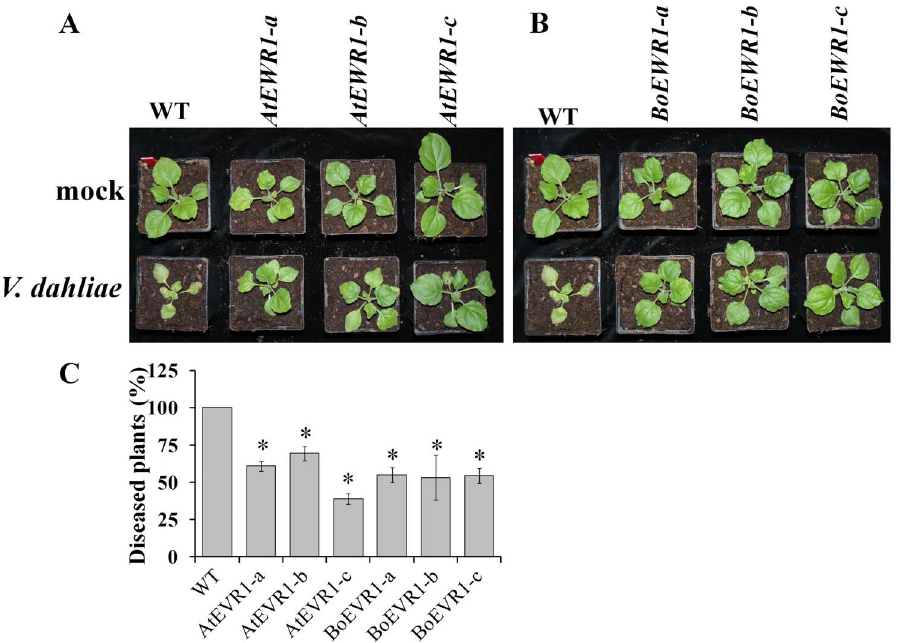
Figure 8. AtEWR1 and BoEWR1 over-expression in N.benthamiana results in resistance to V.dahliae . Typical symptoms of V. dahliae on the wild-type (WT), AtEWR1 ( AtEWR1 - a, b, c ) (A) and BoEWR1 ( BoEWR1 - a, b, c ) (B) over-expressing N. benthamiana plants. Pictures were made at 10 dpi and the upper and lower rows indicate mock- and V. dahliae -inoculated plants, respectively. (C) Percentage of plants (n=20) that showed clear Verticillium symptoms at 10 dpi. Bars represent averages of three biological replications with standard deviations, and asterisks indicate significance differences when compared with WT ( P =0.01).